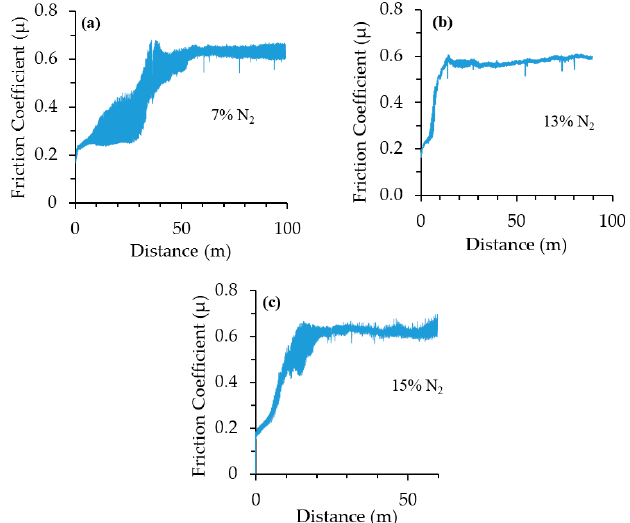
Figure 10. Coefficient of friction of Ta–Si–N films deposited with ( a ) 7%, ( b ) 13%, and ( c ) 15% N 2 .